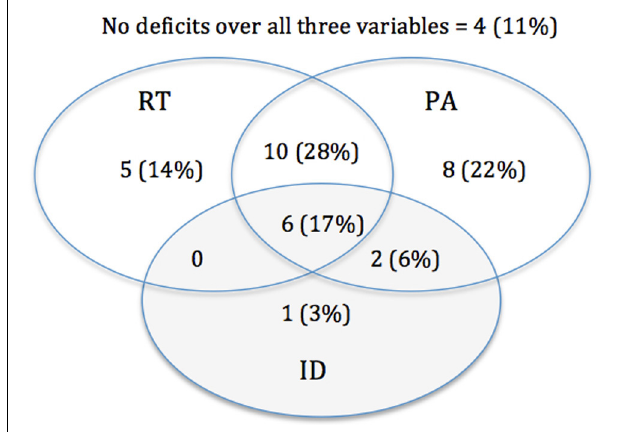
FIGURE 1 | Distribution of RT, PA, and ID deficits in the total sample of 36 dyslexic adult participants. Measured in absolute numbers and percentages of impaired